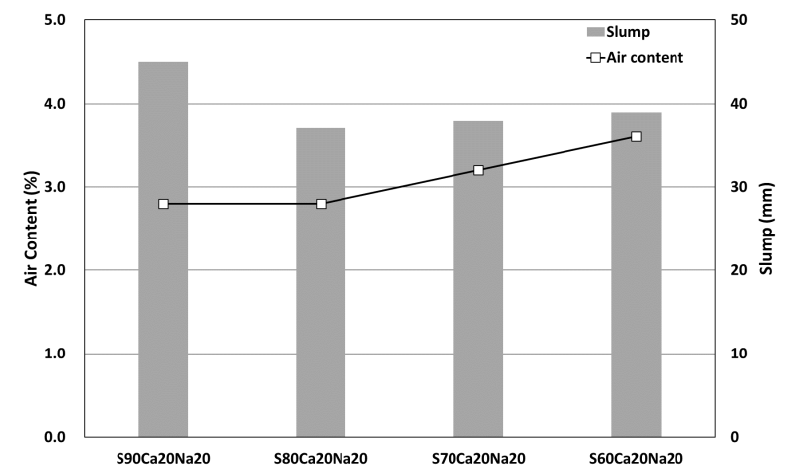
Figure 2. Slump and air content test results.